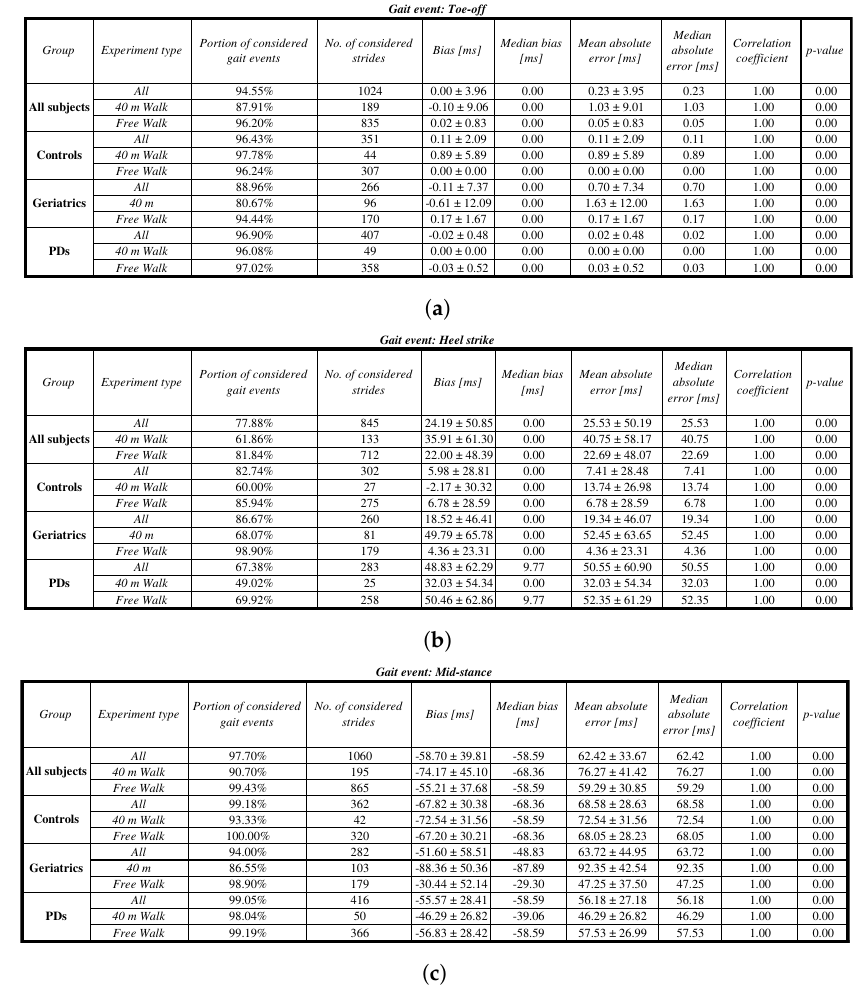
Figure 10. Comparison of the performance of proposed approach with relevant state-of-the-art approaches performed using the eGait dataset.